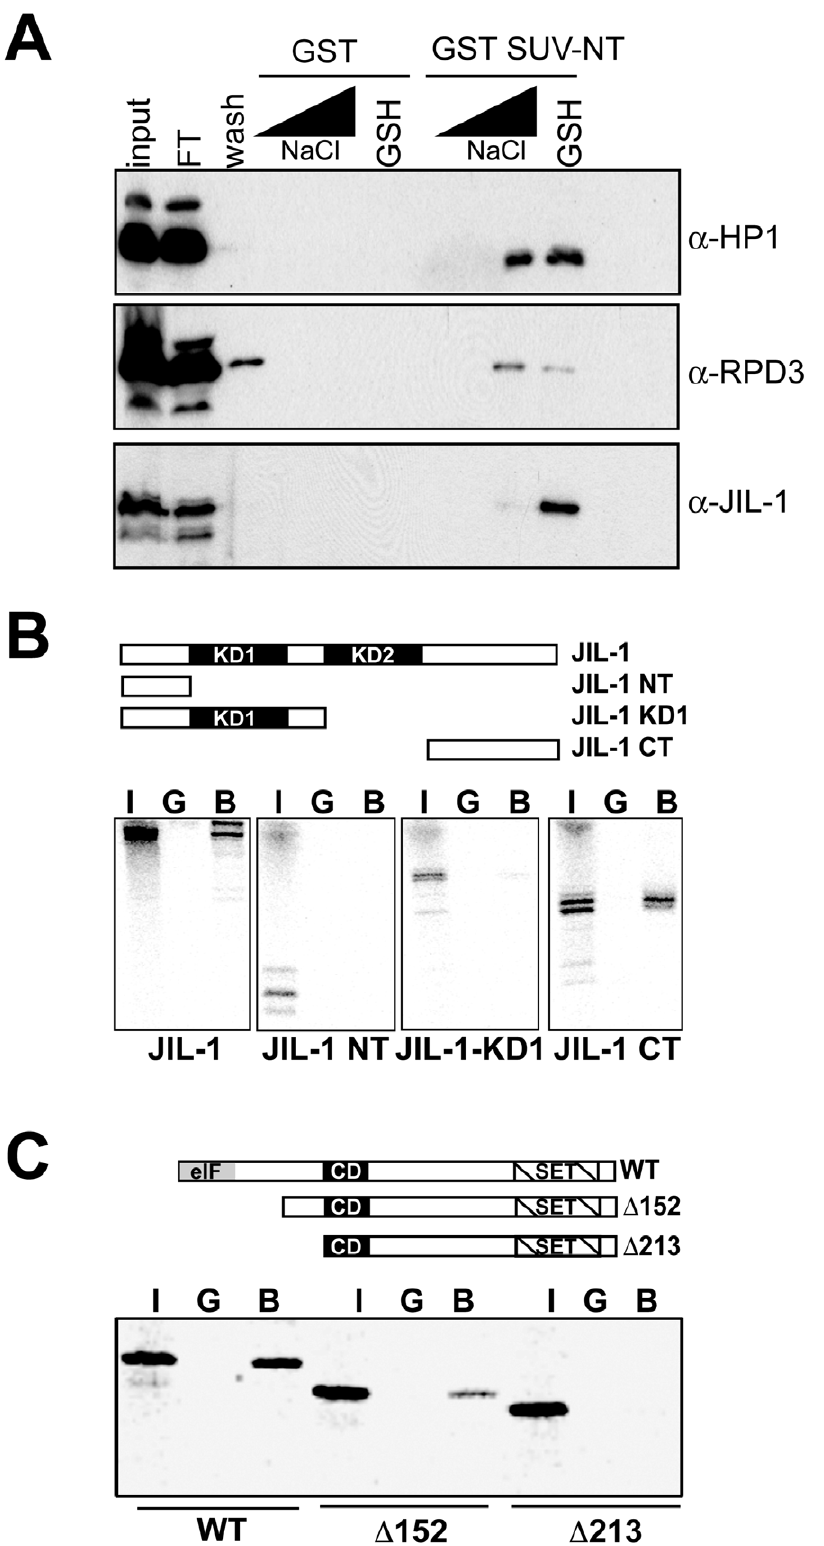
Figure 1. Identification of the chromosomal kinase JIL-1 as a novel interaction partner of SU(VAR)3–9. ( A ) Western Blot analysis of the eluates (250, 500, 750 mM Nacl and reduced Glutathion, GSH) from the indicated columns, identifies JIL-1 as a novel interactor of SU(VAR)3–9. 15 m l of each fraction were separated by SDS-PAGE and subjected to Western Blot analysis using the indicated antibodies (FT= flow through). ( B ) The JIL-1 C-terminus mediates the interaction with SU(VAR)3–9. Top : Schematic representation of the JIL-1 derivatives used for the in vitro translation reaction indicating the characteristic domain structure of JIL-1 (KD1/KD2 = kinase domain 1 and 2). Bottom : GST pull-downs using bacterially expressed GST